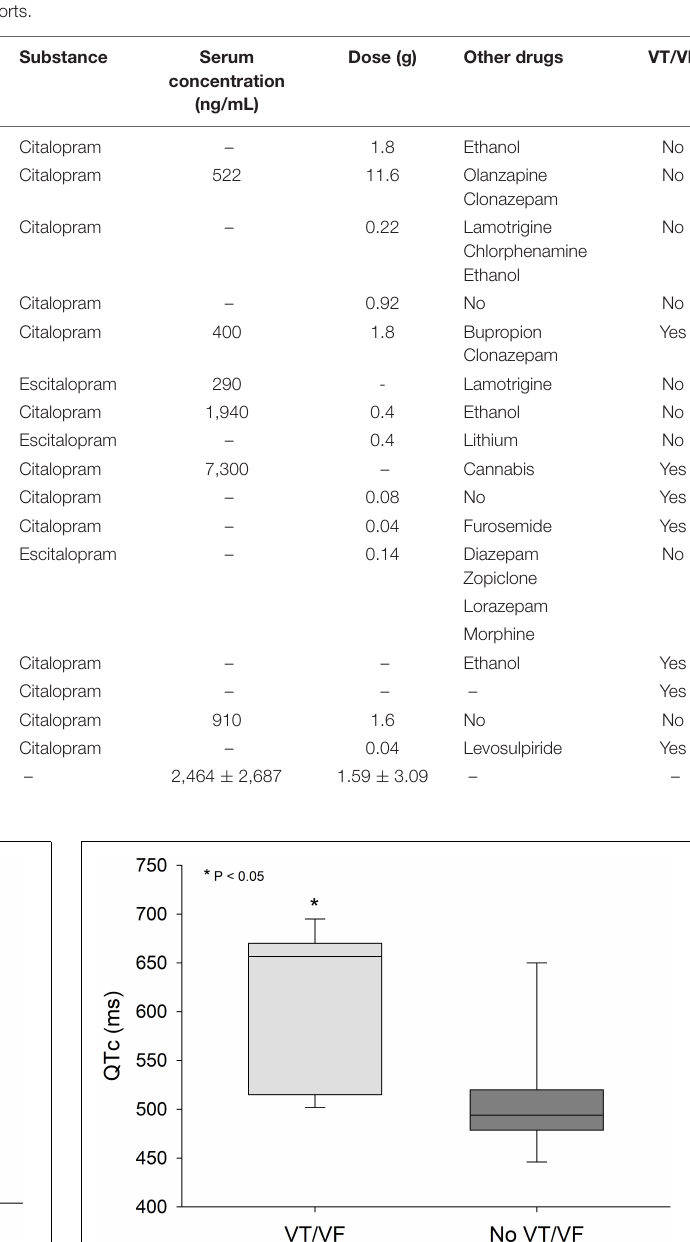
FIGURE 1 | QRS/QTc values were significantly lower ( p < 0.0005) in patients that developed VT/VF after first ECG-recording compared to patients that remained in sinus rhythm. Solid line: Median, box-plot: 25- to 75-persentile, and error bars: 5- and 95-persentile. *Difference from «No VT/VF group» ( p < 0.05). VF, ventricular fibrillation; VT, ventricular tachycardia.